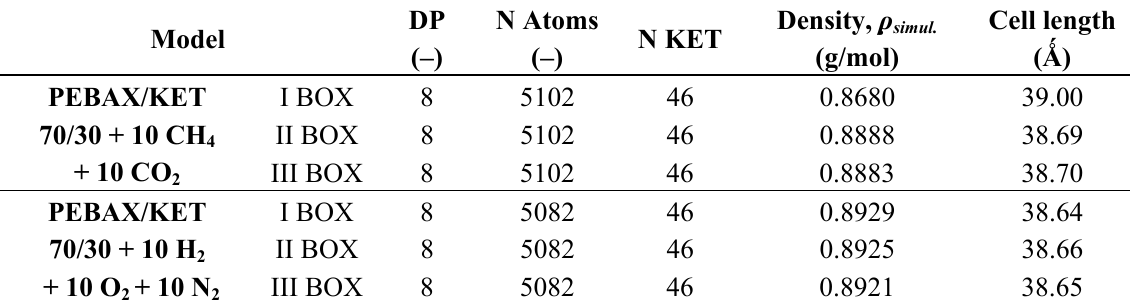
Table 1. Properties of the atomistic packing models for three samples of PEBAX/KET at different compositions. DP is the degree of